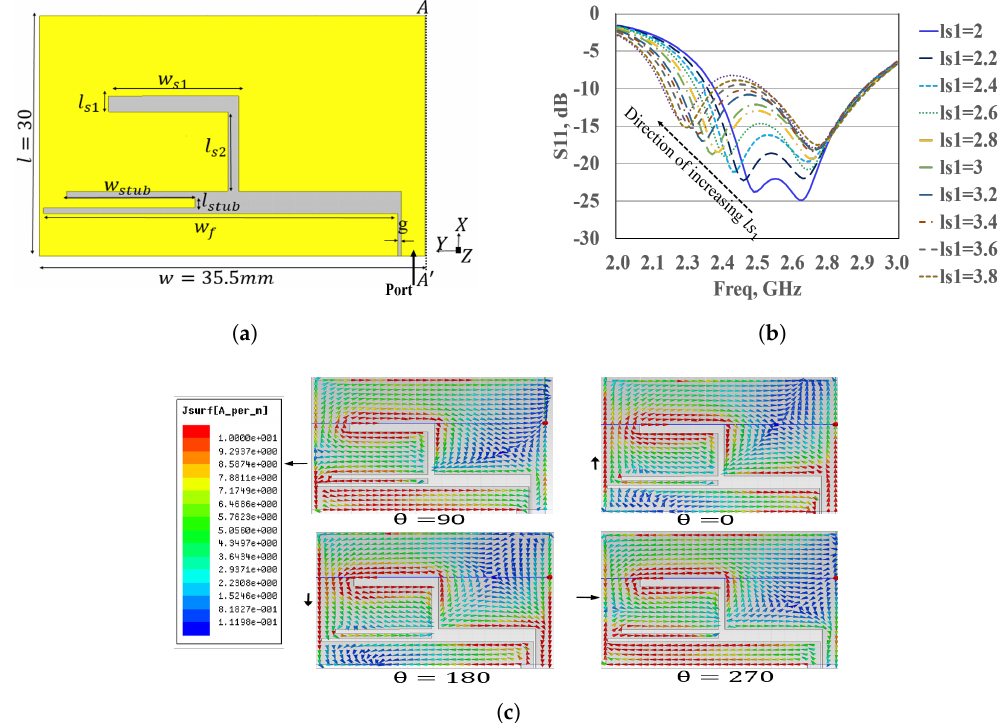
Figure 5. The antenna configuration and parametric study. ( a ) The CPW antenna layout, the dimensions are as follows: w s 1 = 12 mm, l s 1 = 2 mm, l s 2 = 9.9 mm, w stub = 11.84 mm, l stub = 1.2 mm, w f = 32.7 mm, g = 0.3 mm; ( b ) the effect of changing the L-slot width l s 1 ; ( c ) surface current distribution on the antenna structure for different phase excitation at frequency 2.45 GHz.